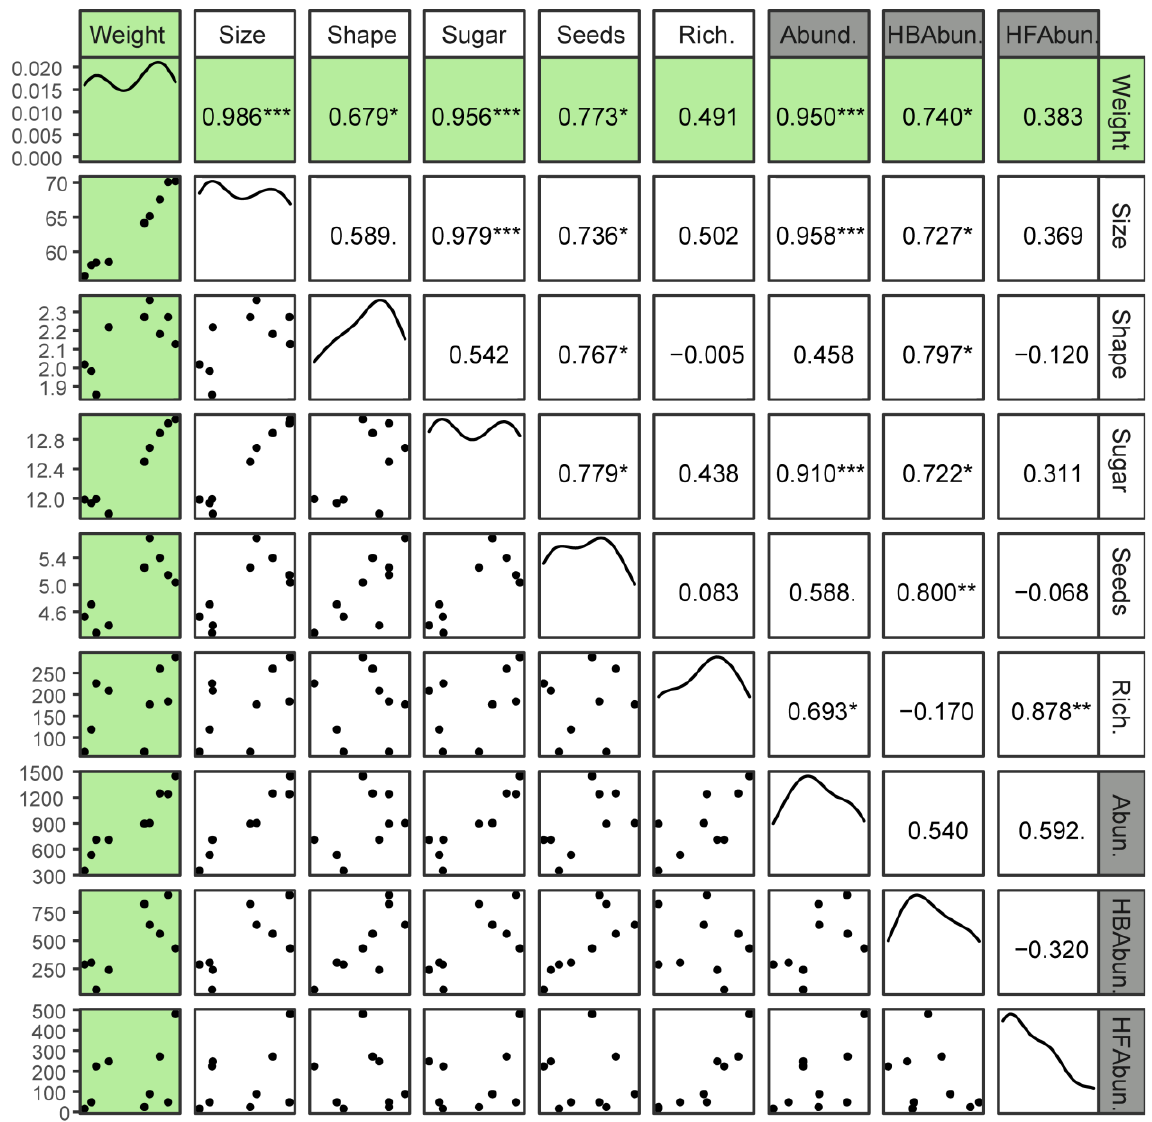
Figure 6. Correlation matrix showing the key apple quality measurements and measurements of per orchard ( N = 9) abundance and diversity. Variables included, in order, are mean apple weight (g), mean apple size in (mm), mean apple shape which is a malformation score from; 1 – badly misshapen and unmarketable, 2 – somewhat malformed and 3 – perfectly symmetrical and marketable quality, mean sugar concentration (% BRIX), mean number of seeds per apple, total richness, total abundance, abundance of honeybees (HB) and abundance of hoverflies (HF). Mean weight (highlighted in green) was used as the response variables in a linear mixed effects model. Abundance was the only variable included in the best model (lowest AIC) and HB abundance and HF abundance were included in the best model if abundance was excluded (all highlighted in grey). Value on the upper triangle is the Pearson’s correlation coefficient and the * refer to the P -value significance level; *< 0.05, **< 0.01, ***<